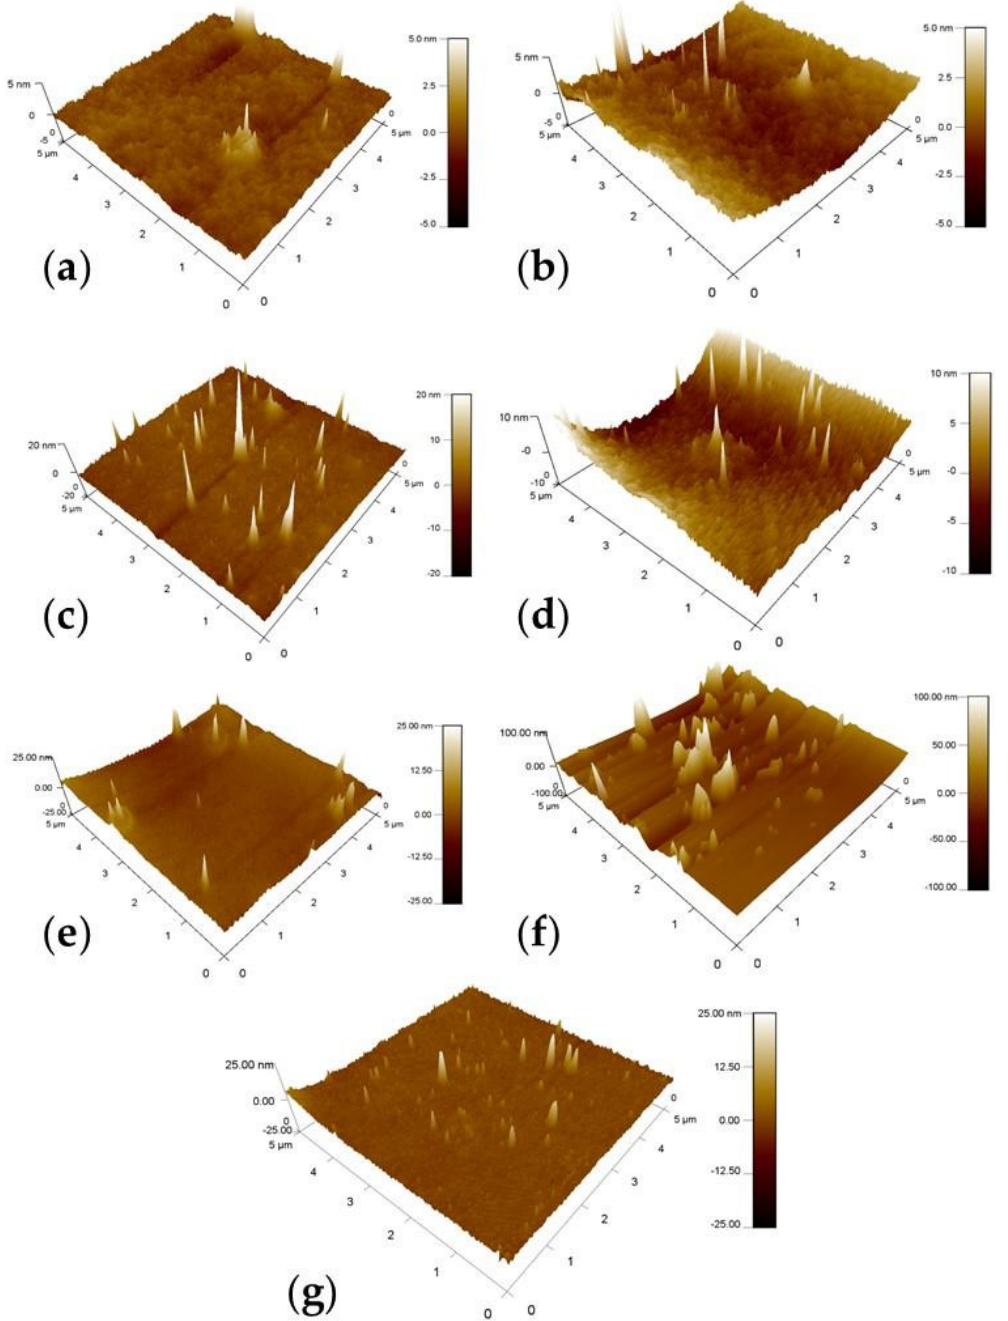
Figure 5. AFM micrographs of ( a ) S-, ( b ) S-AC-, ( c ) S-CE-, ( d ) S-CL-, ( e ) S-EG-, ( f ) S − ST-, and ( g ) S- RB-coated samples. ( g ) S-RB-coated